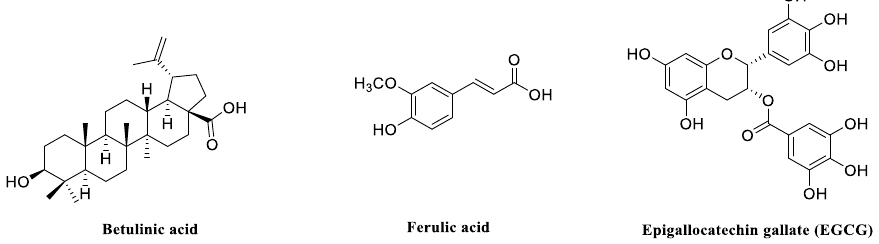
Figure 1. Structures of betulinic acid, ferulic acid, and epipallocatechin gallate (EGCG).